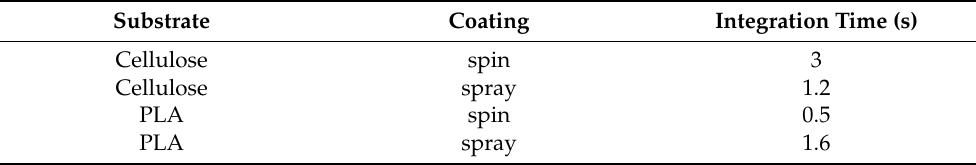
Table 1. Integration time for one frame set for each sample.